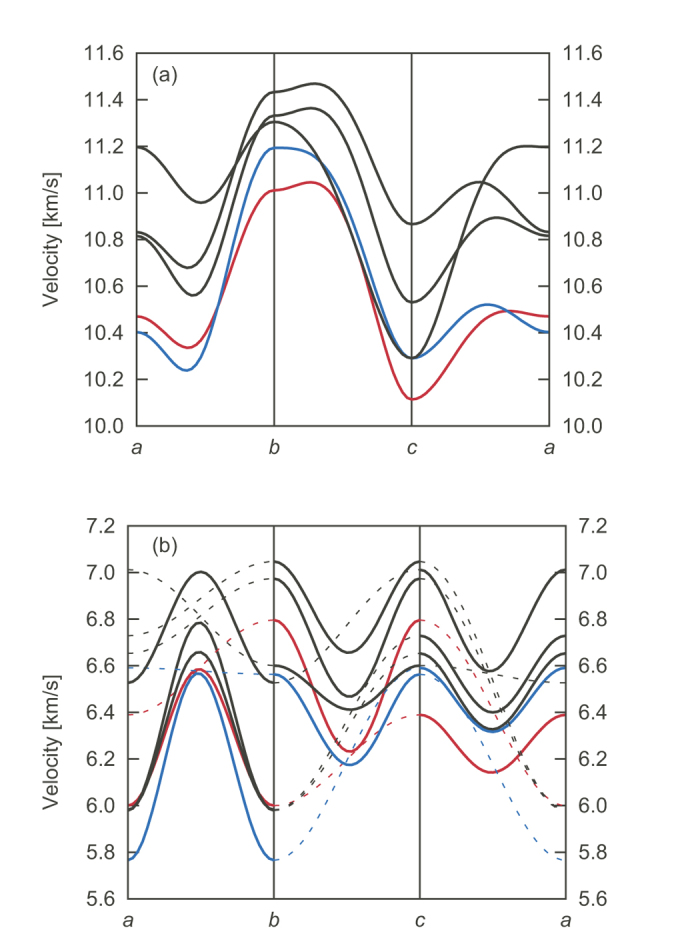
Velocity surface of bridgmanite.Longitudinal (a) and transverse (b) waves from the present study (red lines for Mg-Bdg and blue for (Fe,Al)-Bdg) and by BLS171819 (black lines). Solid and broken lines indicate the polarization vector is in-plane or out-of-plane, respectively, in (b).